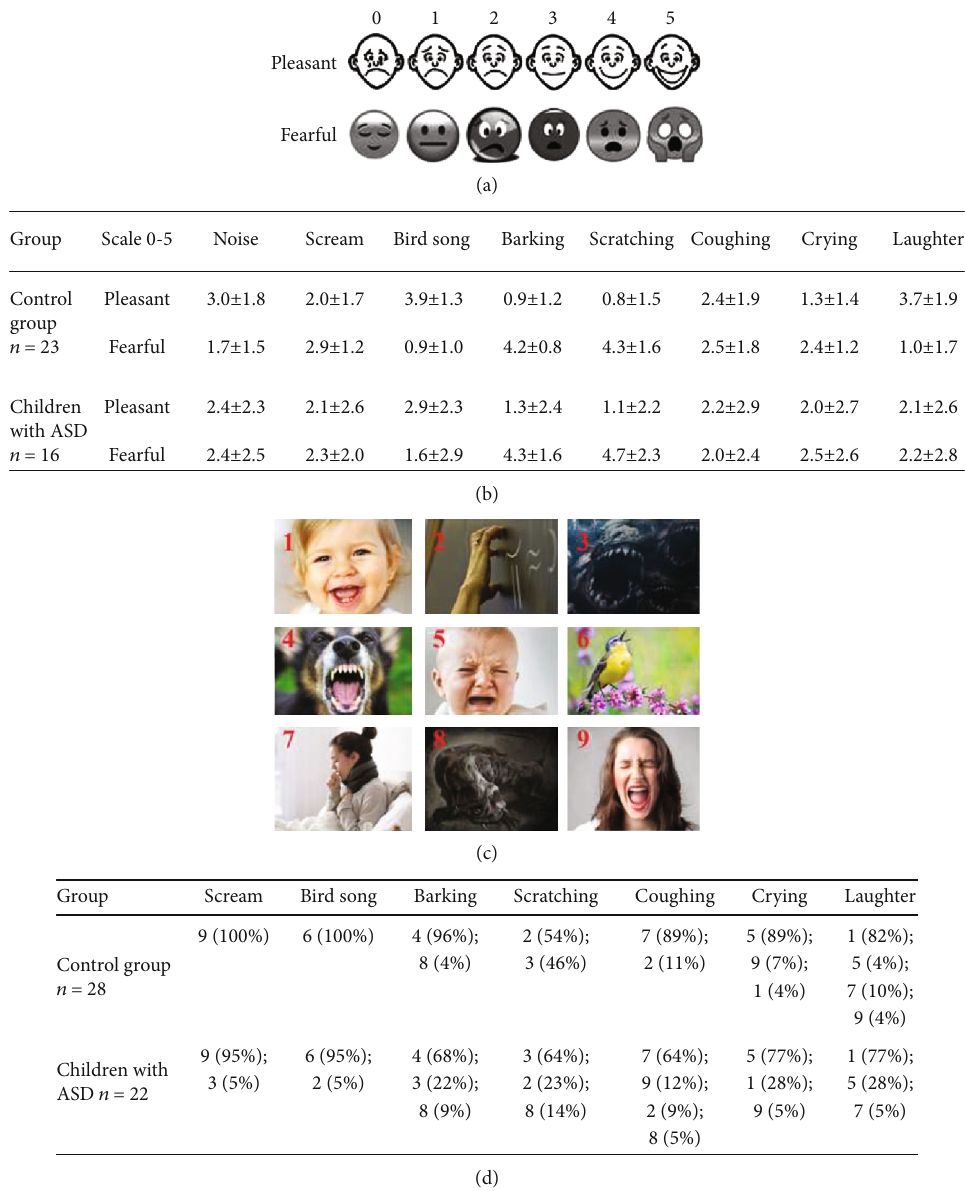
Figure 1: (a) Schematic example of the analog scales of pleasantness and fear (0 – 5). (b) Stimulus assessments using analog scales by both groups of participants. (c) Images used to identify sounds. (d) Recognition of stimuli using images in both